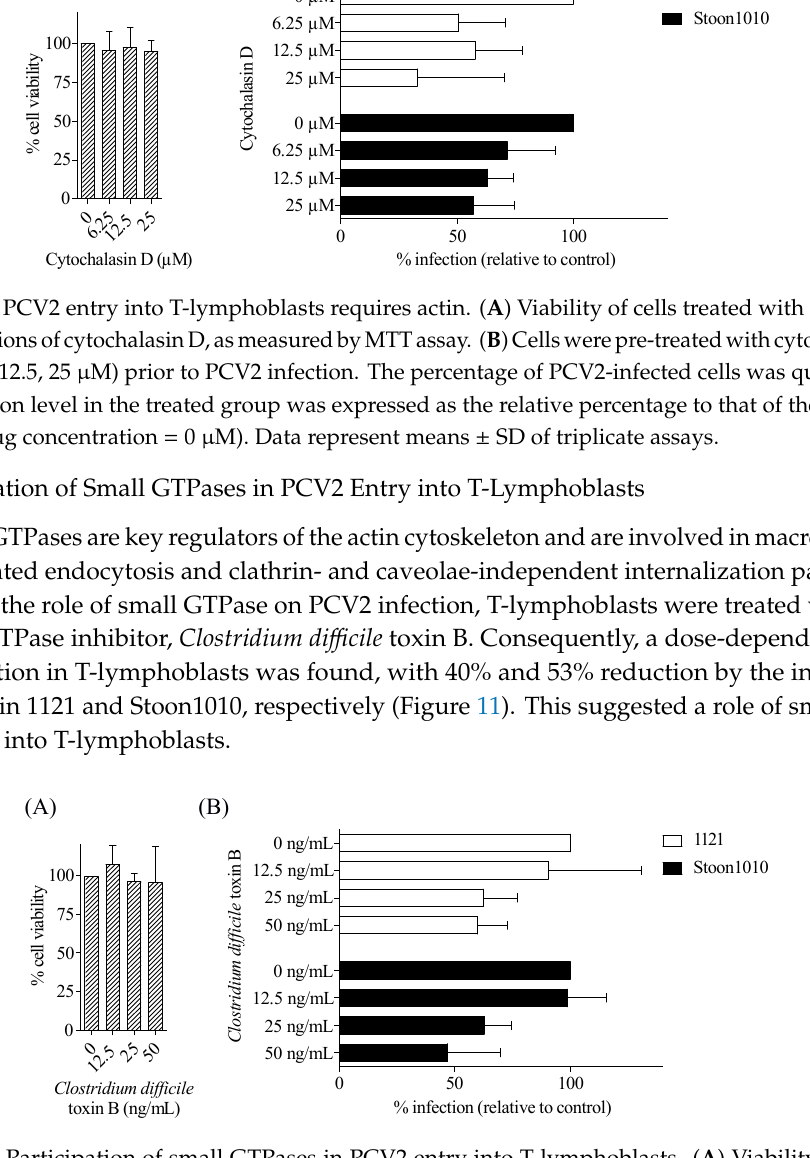
Figure 11. Participation of small GTPases in PCV2 entry into T-lymphoblasts. ( A ) Viability of cells treated with different concentrations of Clostridium difficile toxin B, as measured by MTT assay. ( B ) Cells were pre-treated with Clostridium difficile toxin B (0, 12.5, 25, 50 ng/mL) prior to PCV2 infection. The percentage of PCV2-infected cells was quantified. The infection level in the treated group was expressed as the relative percentage to that of the control group (drug concentration = 0 ng/mL). Data represent means ± SD of triplicate assays.